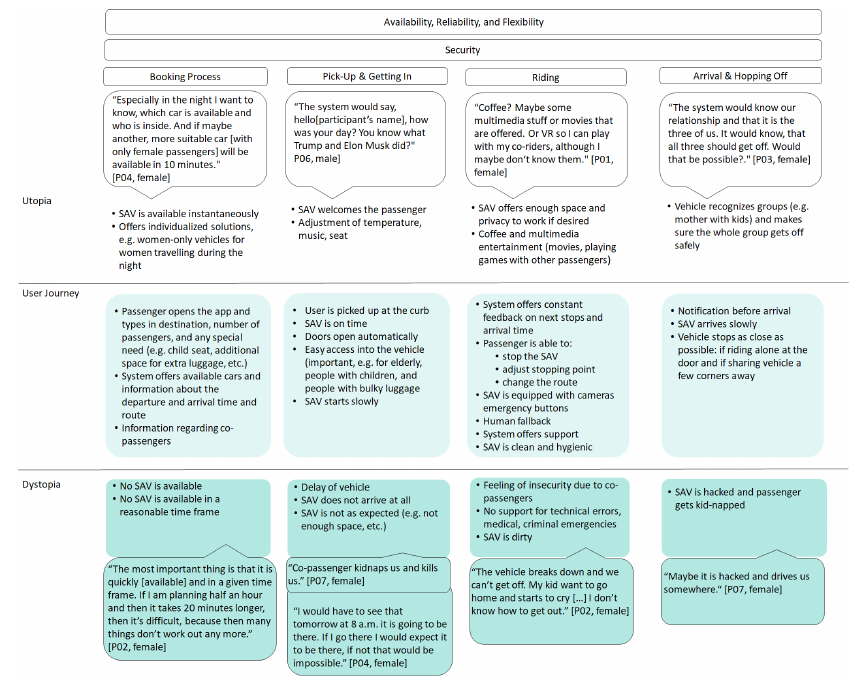
Figure 2. Derived passenger journey derived from participants’ statements, structured according to the different phases of a trip. Statements referring to utopian ( top ) and dystopian ( bottom ) fantasies were integrated to derive common themes. Derived design requirements are visible in the